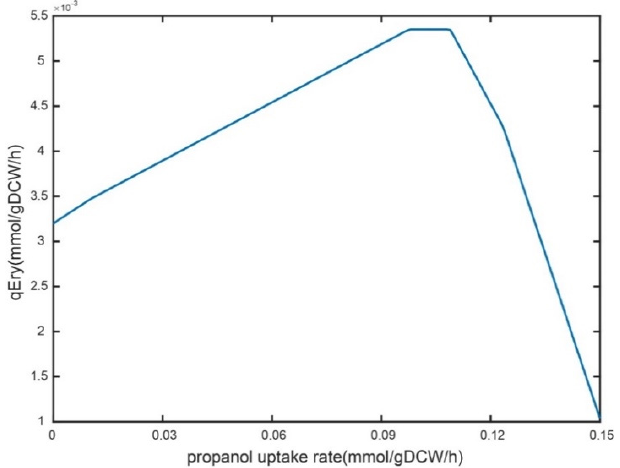
Figure 4. Robustness analysis of the n-propanol uptake rate to the specific erythromycin synthesis rate.